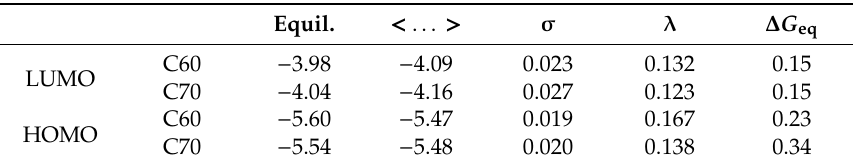
Table 1. HOMO and LUMO energies at the equilibrium geometry (“Equil.”), their expectation values over MD trajectories (“ < ... > ”), standard deviations of HOMO and LUMO distributions over MD trajectories (“ σ ”), and reorganization energies λ and driving forces ∆ G eq for electron and hole transport in C60 and C70 computed in [48]. All values are in eV. Equil. < ... > σ λ ∆ G eq C60 − 3.98 − 4.09 0.023 0.132 0.15 LUMO C70 − 4.04 − 4.16 0.027 0.123 0.15 C60 − 5.60 − 5.47 0.019 0.167 0.23 HOMO − 5.48 0.138